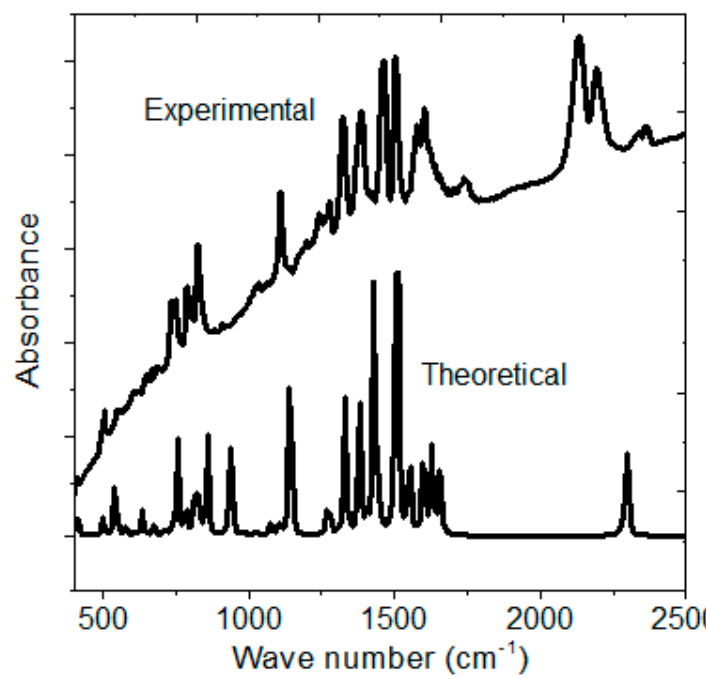
Figure 4. Experimental and calculated IR spectra for ZnQ 2 -TCNQ. Table 2. Experimental and calculated IR frequencies and their assignment for ZnQ 2 -TCNQ.